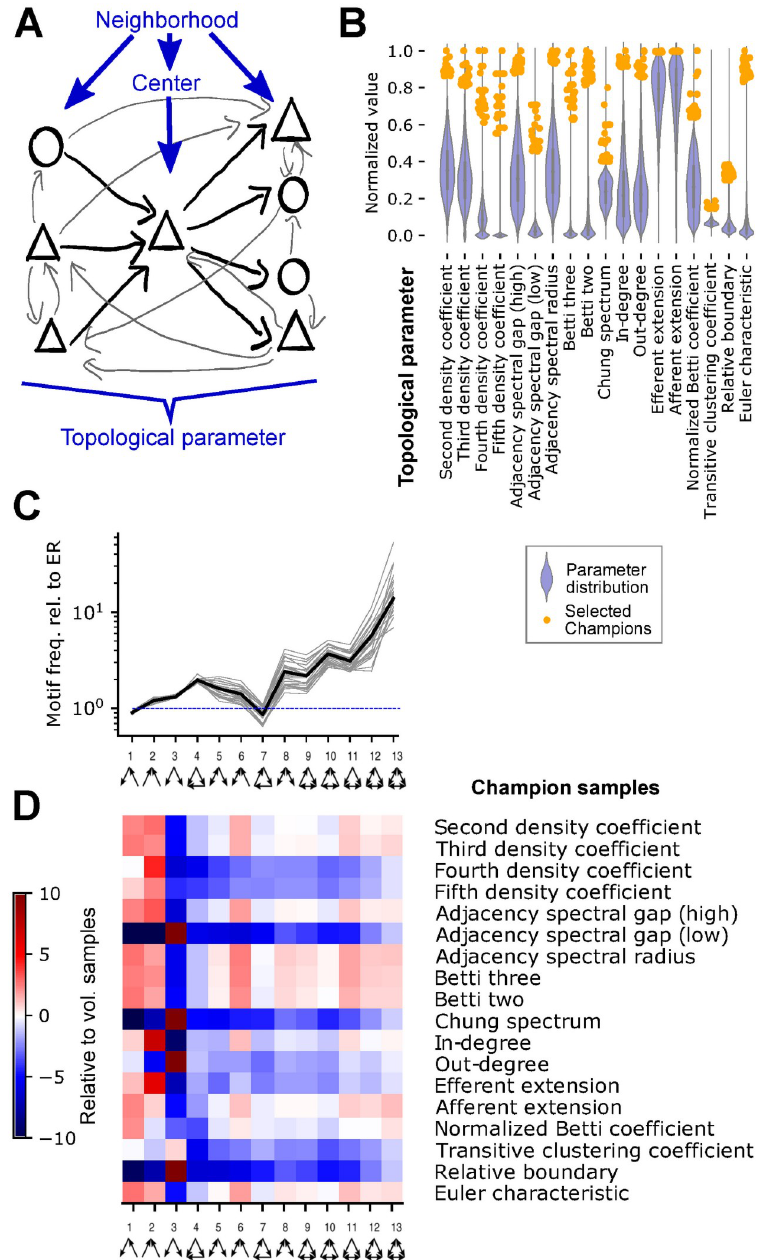
Fig 3. Neuron-neighborhood sampling with uncommon connectivity. A: Neuron-neighborhood sampling: Any neuron can be a center . Its associated neighborhood comprises the center, all synaptically connected neurons, and the connections between them. We then calculate various topological parameters of the neighborhood’s connectivity. B: Blue violinplot: Distribution of various topological parameters, normalized between 0 and 1. Orange dots: Location of the champions , i.e. the 25 neighborhoods of at least 50 neurons with the highest values for a parameter. C: Frequency of triad motifs in volumetric samples with a 175 μm radius relative to an Erdos-Renyi graph with the same number of nodes and edges. Grey: 25 volumetric samples; Black: their mean. D: Over- and under-expression of triad motifs in the connectivity of champion samples of various parameters, normalized with respect to mean/std of the volumetric